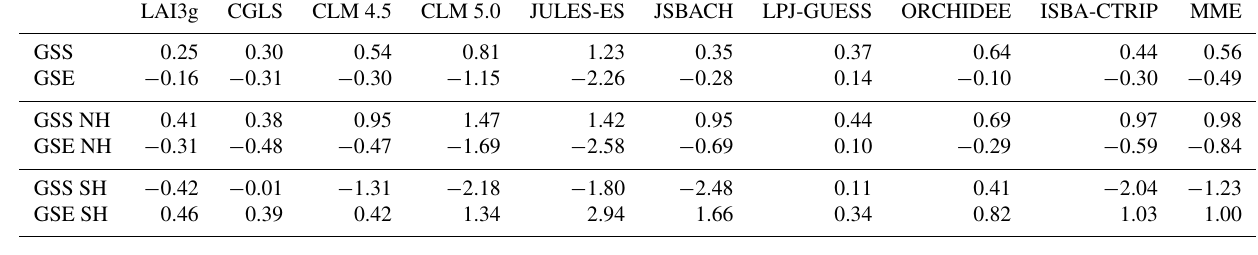
Table 4. Average difference between MODIS and LAI3g, CGLS, each land surface model, and multi-model ensemble mean (MME) in the growing season start (GSS) and growing season end (GSE) timings. Values are reported in months for global, Northern Hemisphere (NH), and Southern Hemisphere (SH). Positive values stand for later timings, and negative values correspond to earlier timings. LAI3g CGLS CLM 4.5 CLM 5.0 JULES-ES JSBACH LPJ-GUESS